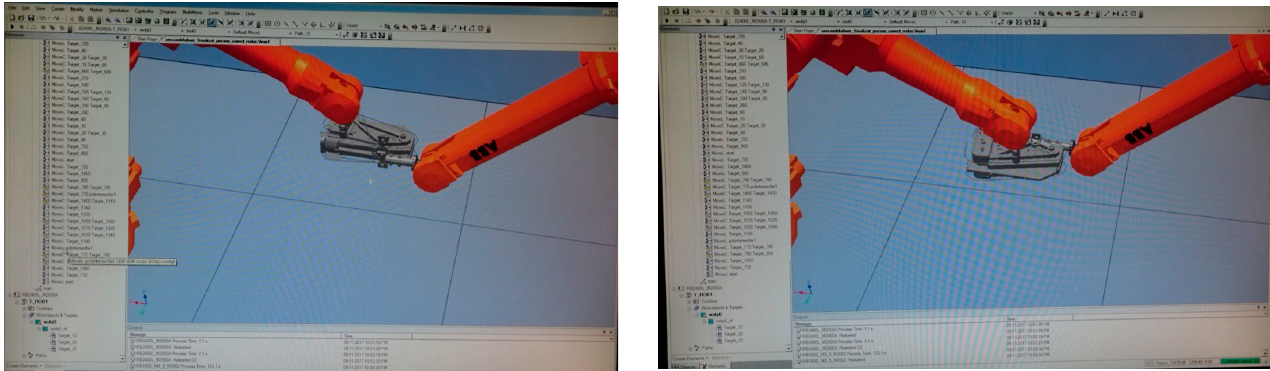
Figure 21. Robot studio robot collaboration simulation.